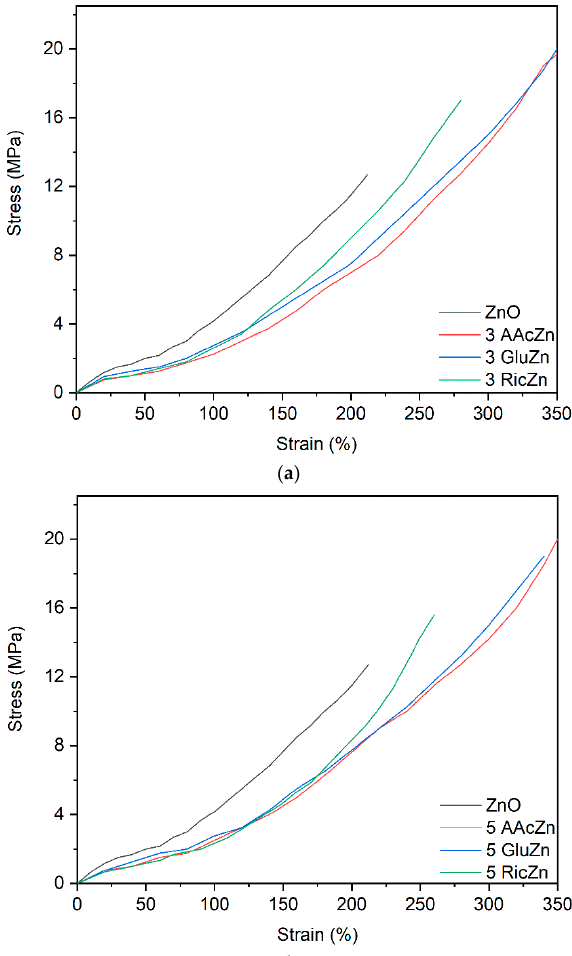
Figure 3. Stress–strain curves of SBR vulcanizates with varying activators: ( a ) 3 phr, ( b ) 5 phr .